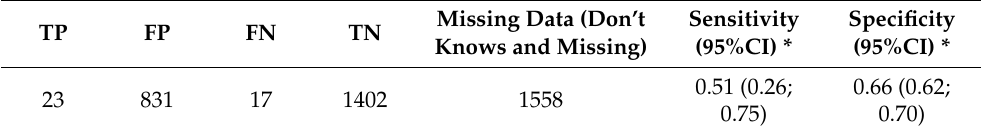
Table 2. Sensitivity and specificity of the current French lead risk questionnaire in predicting BLLs ě 50 µ g/L, France 2008–2009.